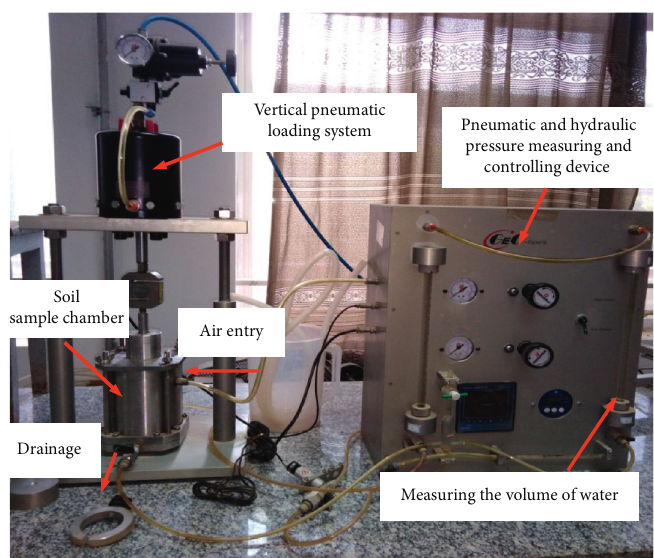
Figure 3: Soil-water characteristic curve pressure plate apparatus.